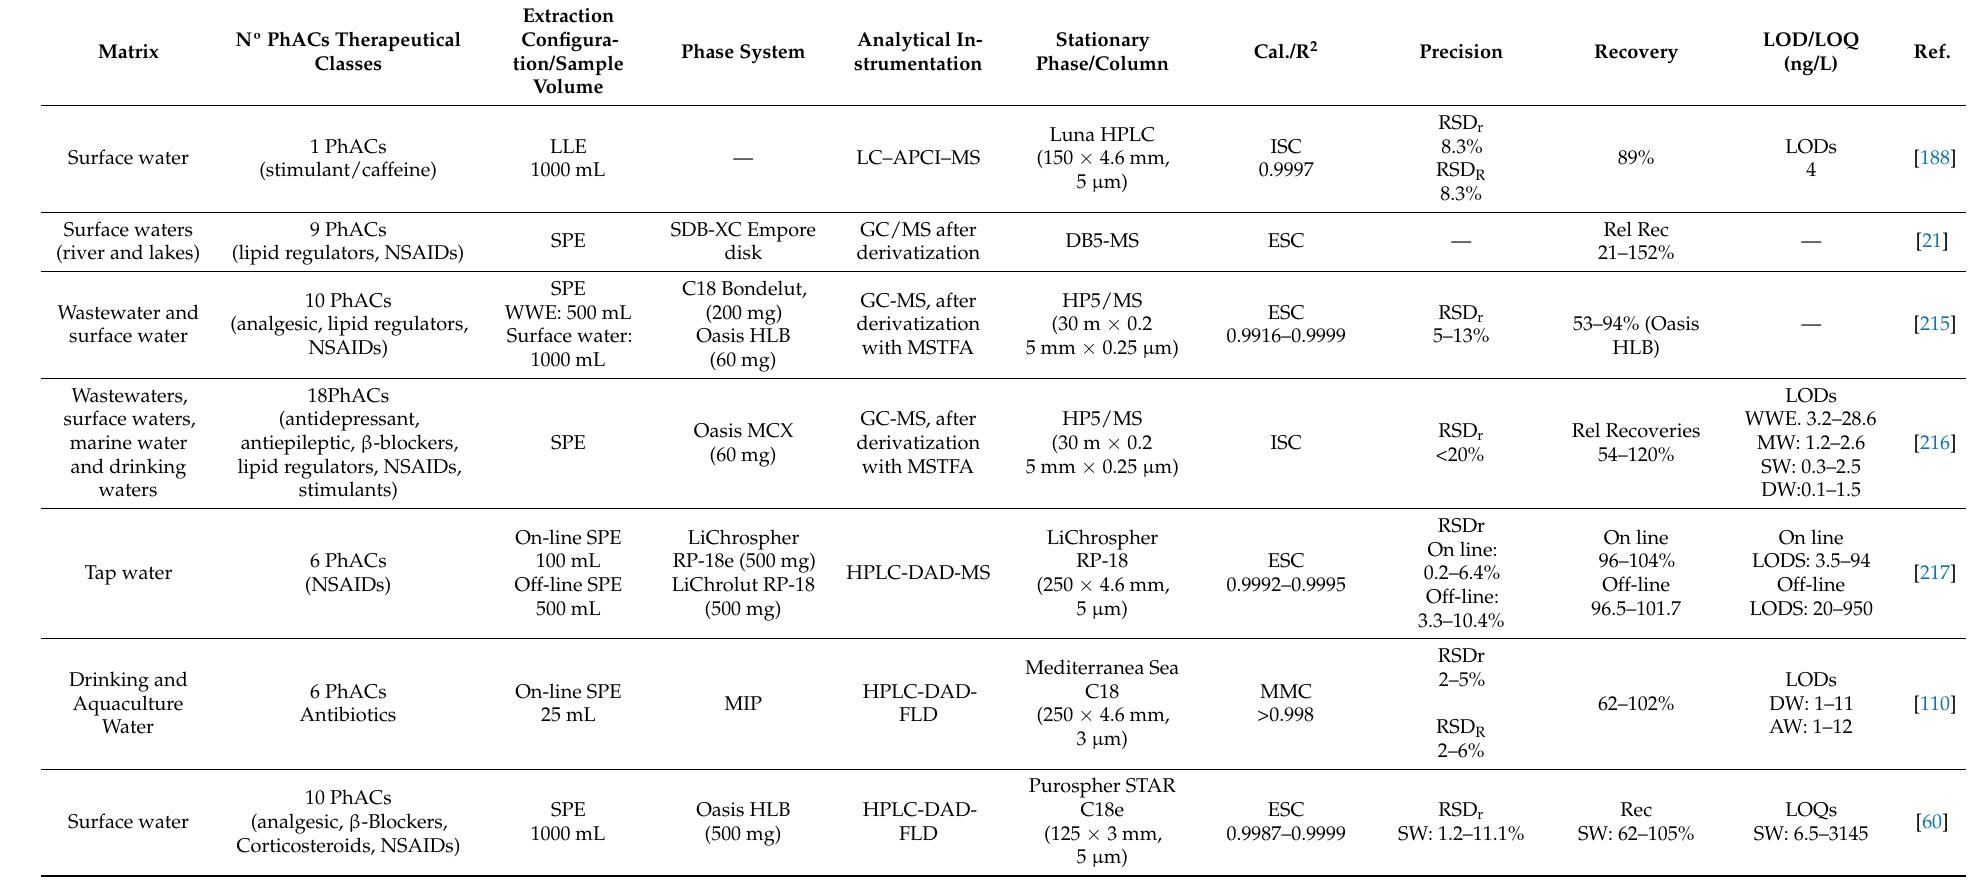
Table 1. Sample preparation methods and chromatographic methods for analysis of PhACs in water